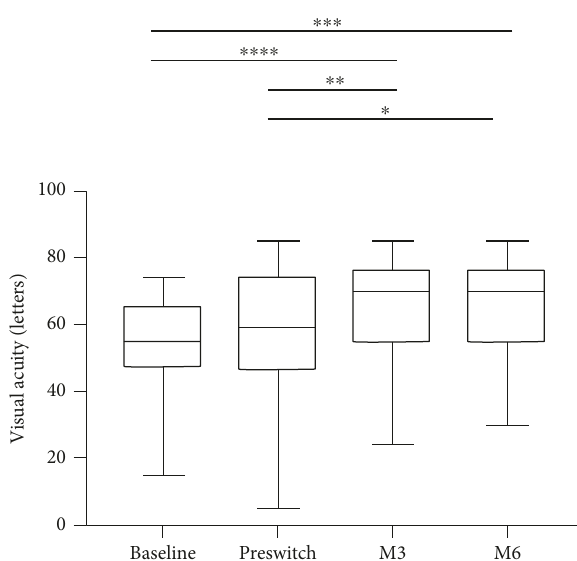
Figure 1: Change in visual acuity (ETDRS chart) over 6 months of follow-up after switch to a fl ibercept. Box plots representing at each time point the distribution of data from bottom to top: minimum, fi rst quartile, median, third quartile, and maximum. p values were obtained after a paired parametric t -test after veri fi cation of the normal distribution. ∗ < 0.05; ∗∗ < 0.01; ∗∗∗ < 0.001; and ∗∗∗∗ < signi fi cant di ff erence in preswitch, M3, and M6 CRT